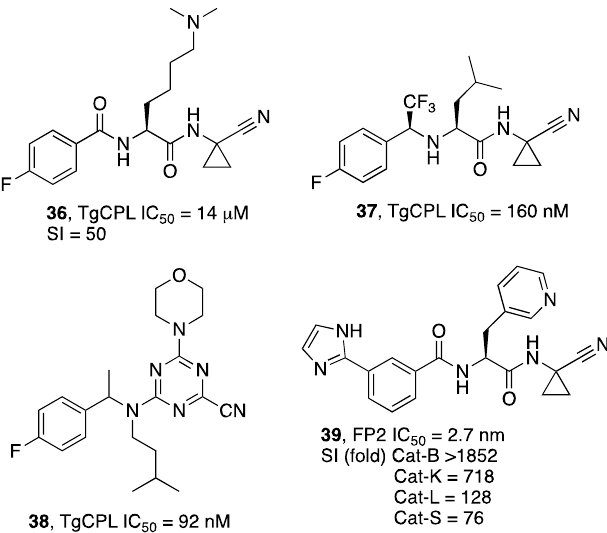
Figure 11. Structures of Tg CPL and FP2 inhibitors ( 34 – 37 ).